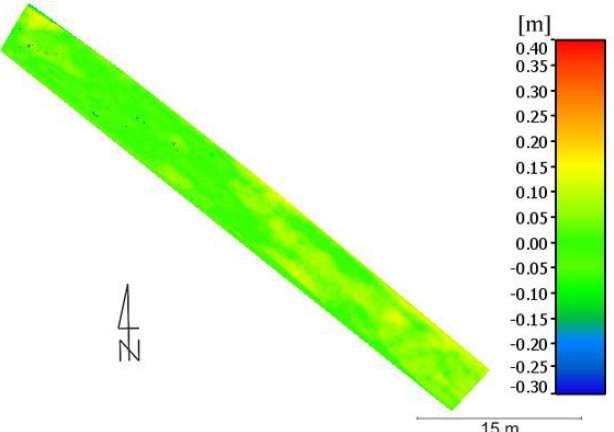
Figure 20. Distribution of differences in the height of the point cloud in relation to the reference model (Test Area No. 3).